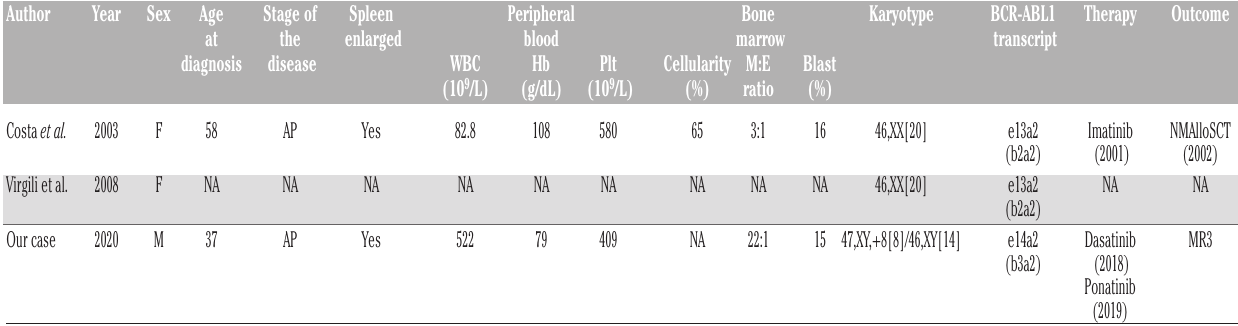
Table 1. Clinical and laboratory features, treatments, and